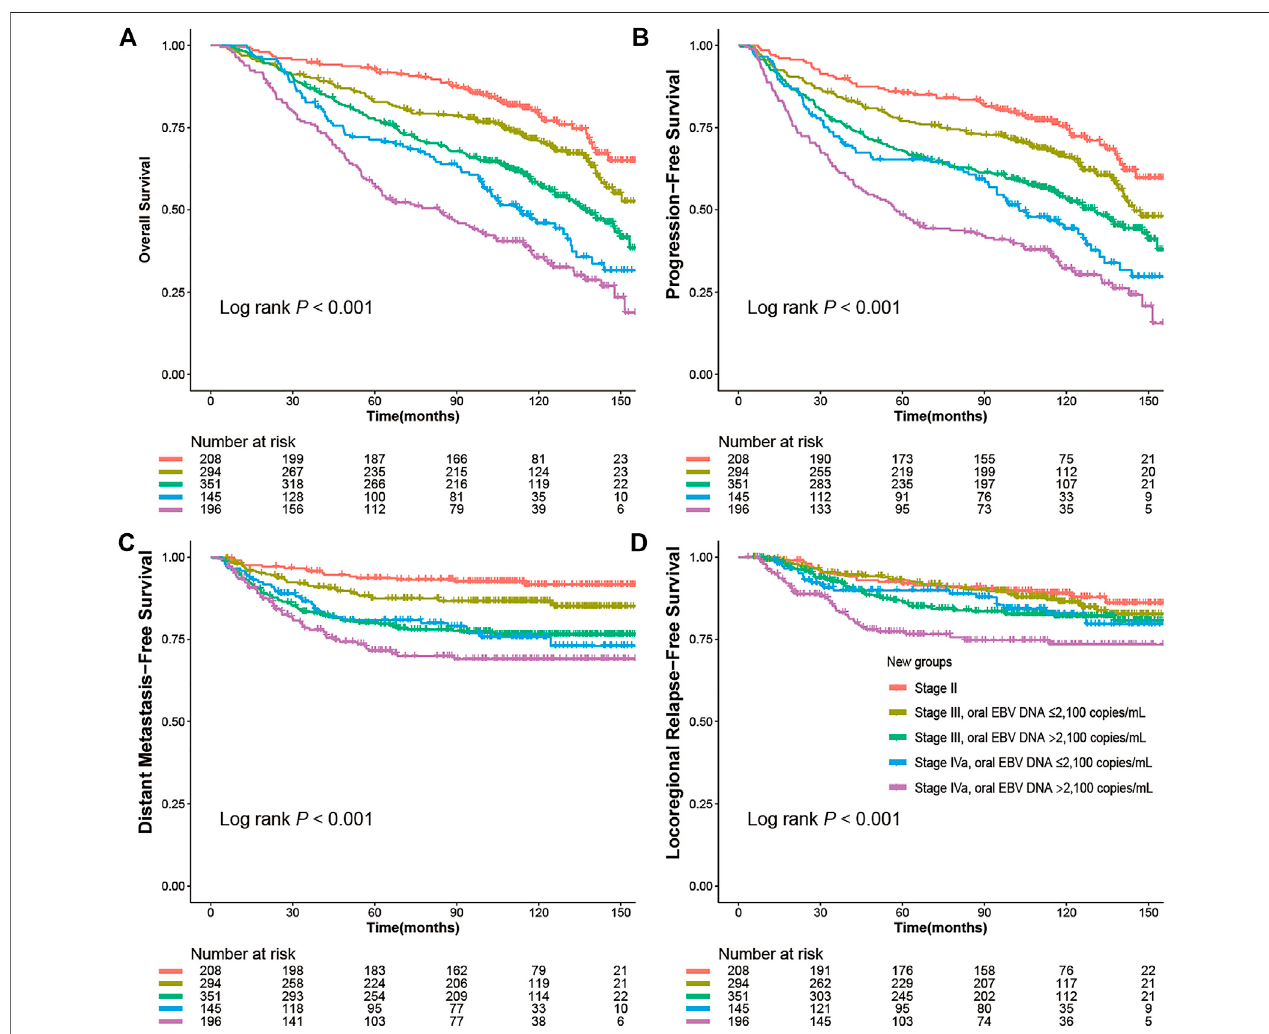
FIGURE 3 | Kaplan – Meier survival curves for NPC survivals segregated by the oral EBV DNA level and TNM staging in all 1,194 NPC patients: (A) overall survival (OS), (B) progression-free survival (PFS), (C) distant metastasis – free survival (DMFS), (D) locoregional relapse-free survival (LRFS).